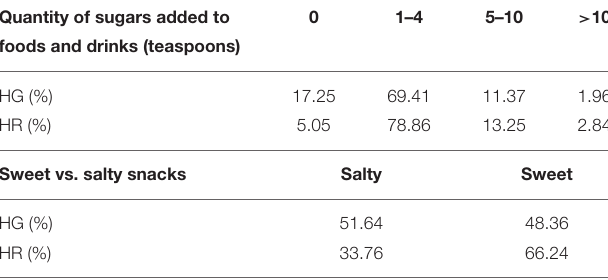
TABLE 3 | Preference for sweet taste in the Hungarian general and Roma populations.